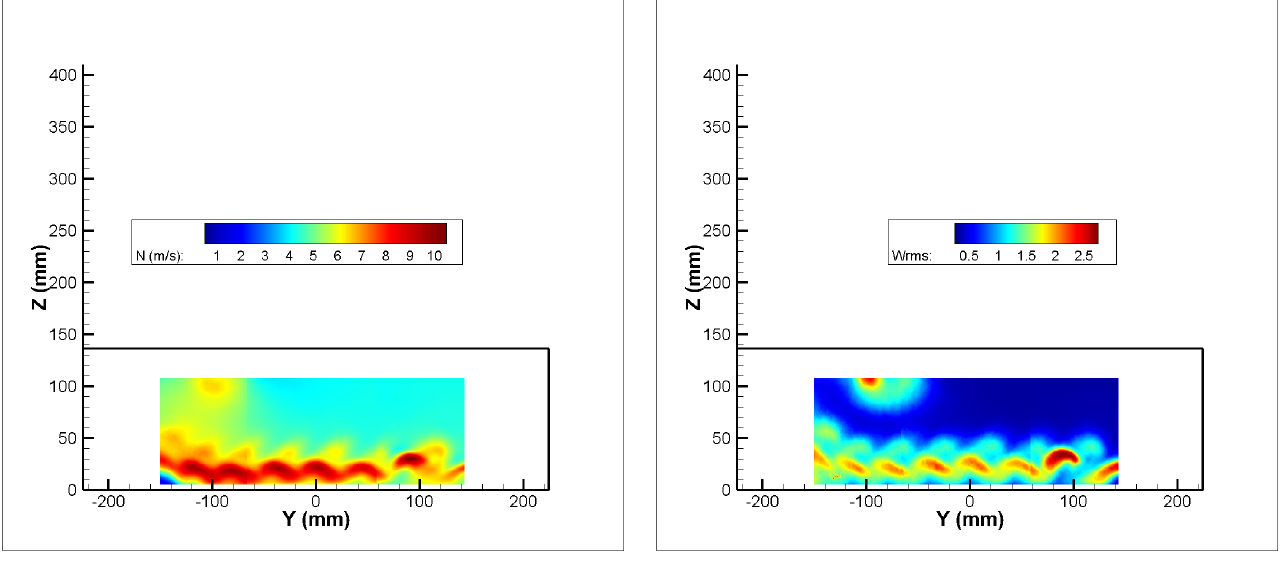
Figure 17. Velocity fields for X-plane X = 138 mm localized midway between the 3rd and 4th rows. Figure 18 details the comparison between measured and simulated velocity mag- nitudes at the 1st, and between the 1st and 2nd rows. The agreement for the first row is satisfactory, though the calculation underestimates the velocity in between the holes.